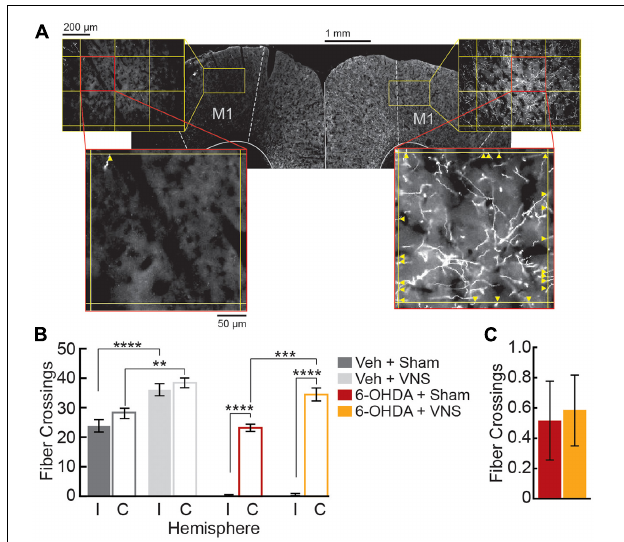
FIGURE 2 | M1 6-OHDA lesions result in severe depletion of TH+ fibers. (A) Representative M1 slice from a 6-OHDA infused subject, stained for TH. Fiber crossings (yellow arrowheads) of an overlaid grid (250 µ m spacing) were counted within M1 ROIs to quantify TH+ fiber innervation in ipsilesional (left) and contralesional (right) hemispheres. (B) Fiber crossings were significantly reduced in ipsilesional (I) compared to contralesional (C) hemispheres following 6-OHDA infusions. VNS treatment increased TH+ fiber innervation within intact M1 hemispheres; this was true in contralateral M1 in both 6-OHDA and vehicle-infused groups, as well as in saline-infused M1. ** p < 0.01; *** p < 0.001; **** p < 0.0001, Tukey post hoc tests. (C) VNS treatment did not alter TH+ fiber counts in 6-OHDA infused